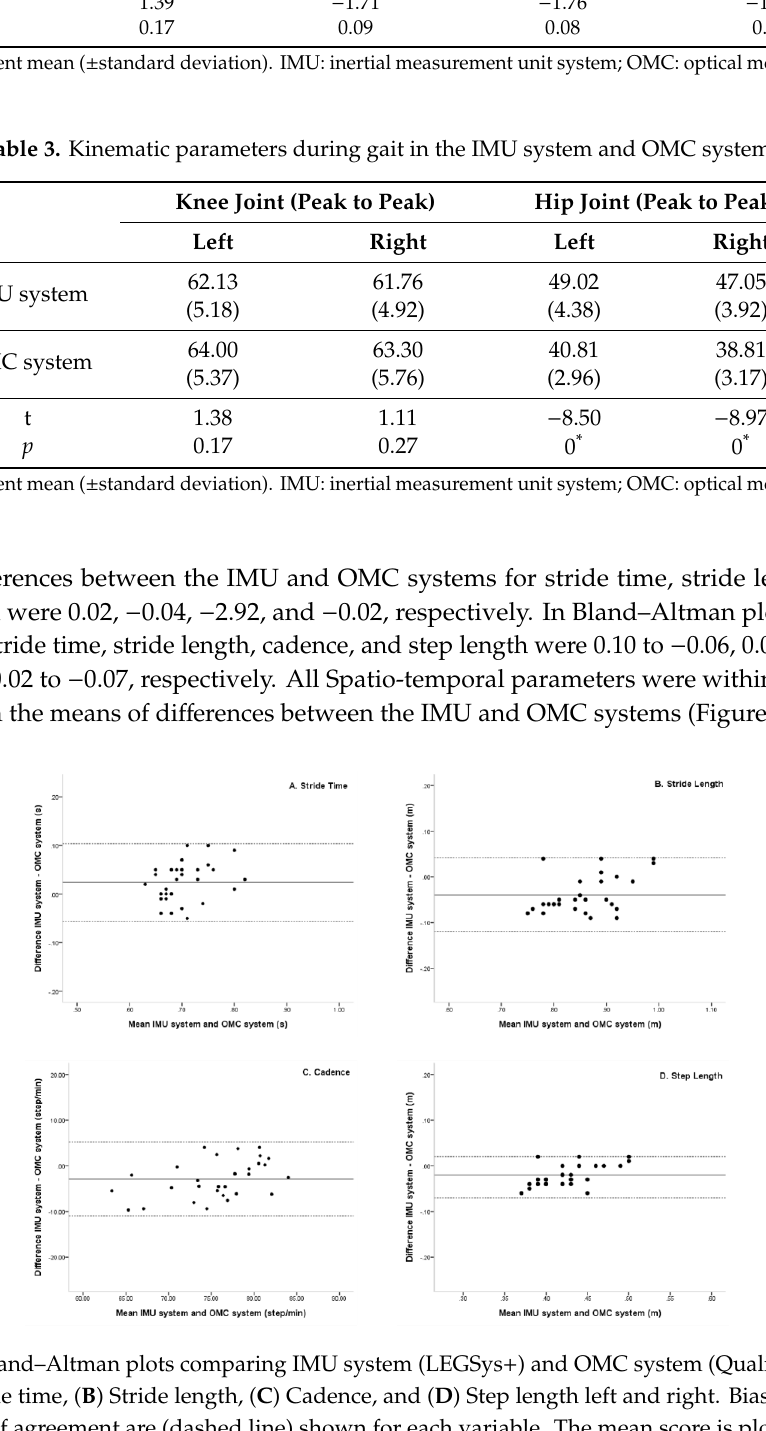
Table 2. Spatio-temporal parameters during gait in the IMU system and OMC system. Stride Time (s) Stride Length (m) Stride Time (s)